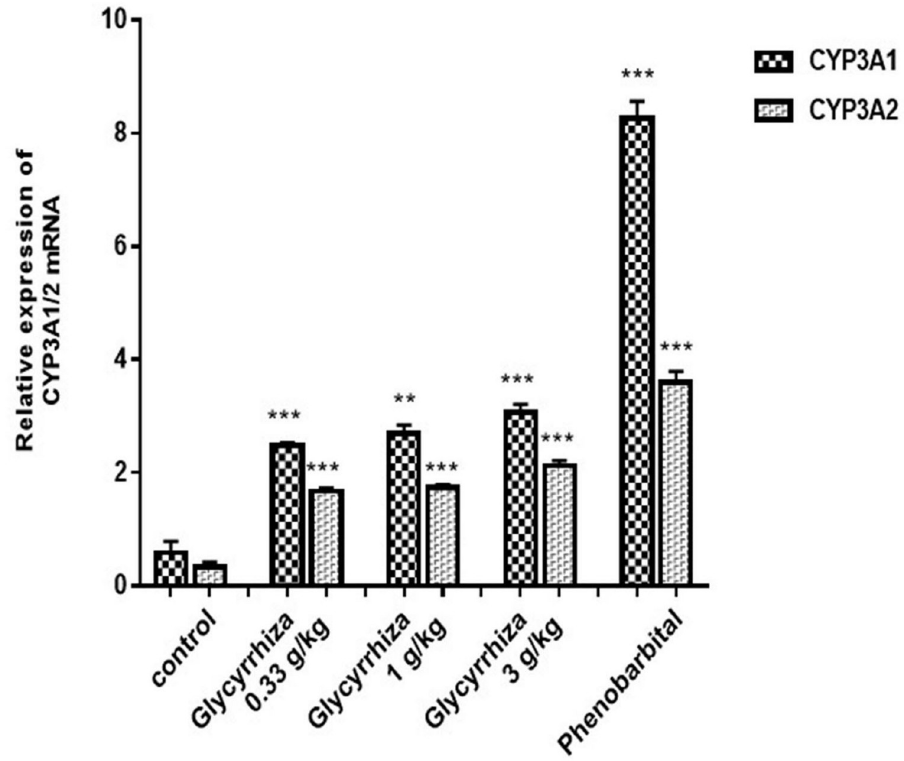
Fig 4. Effect of Glycyrrhizae on CYP3A1/2 mRNA expression. Compared with the negative control group, different concentrations of Glycyrrhiza all could significantly induce the expression of CYP3A 1 / 2 mRNA, �� P < 0.01; ��� P <